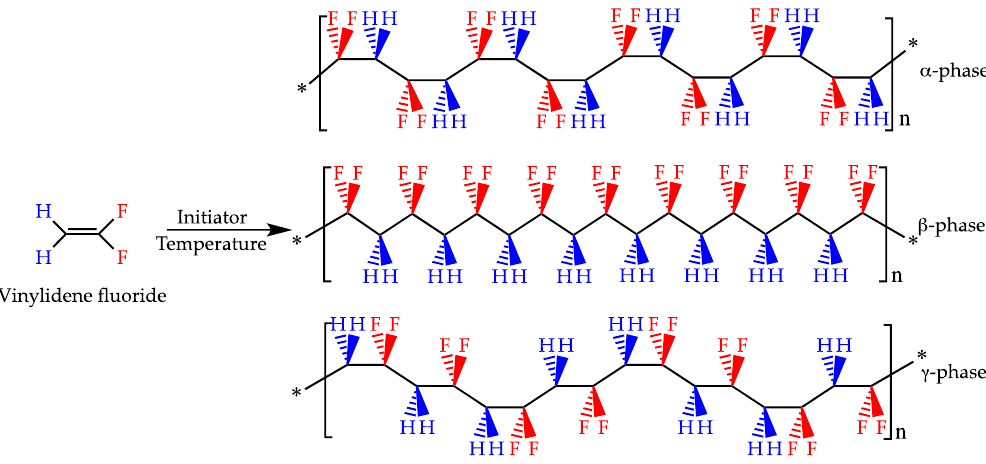
Figure 1. Free radical vinyl polymerization of the monomer vinylidene fluoride to obtain PVDF. Different chain conformations of PVDF in the apolar α-phase and in the polar β- and γ-phases.